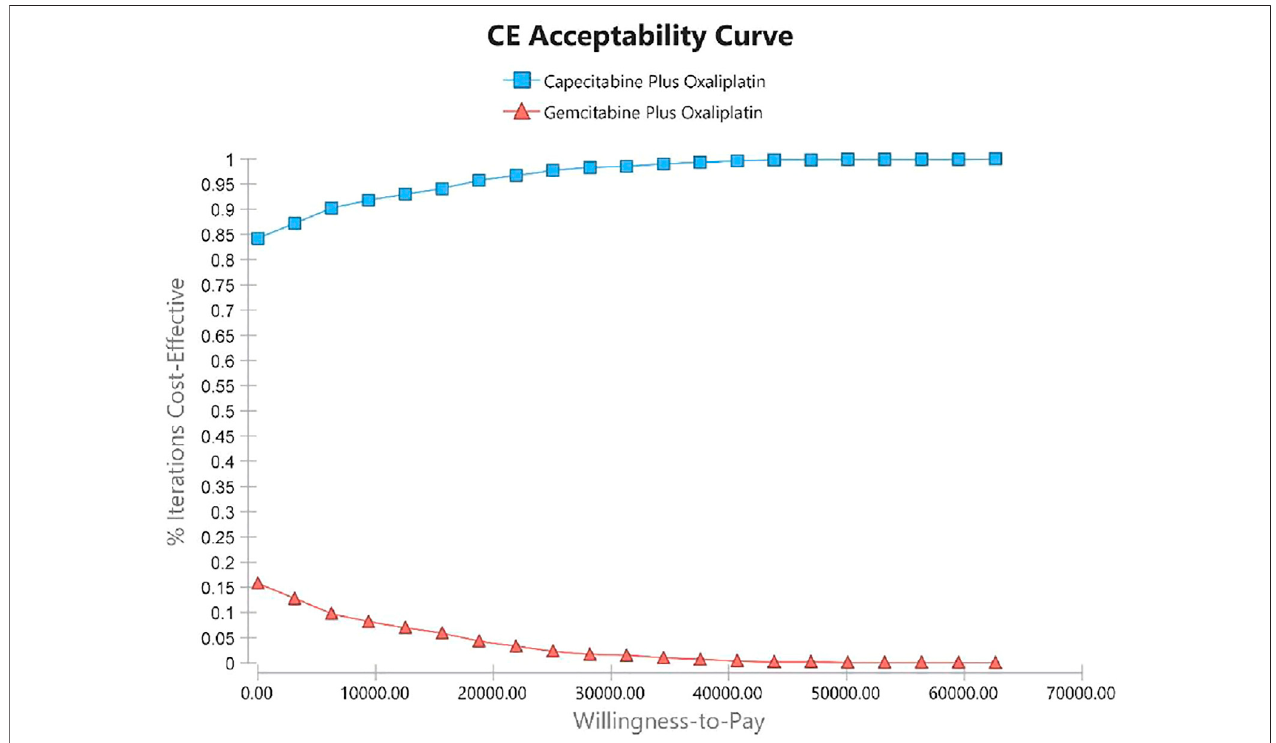
FIGURE 4 | Cost-effectiveness acceptability curves (CEACs). The CEAC represents the economic probability of a drug. The curve shows the percentage of cost- effectiveness simulated using different treatment solutions.